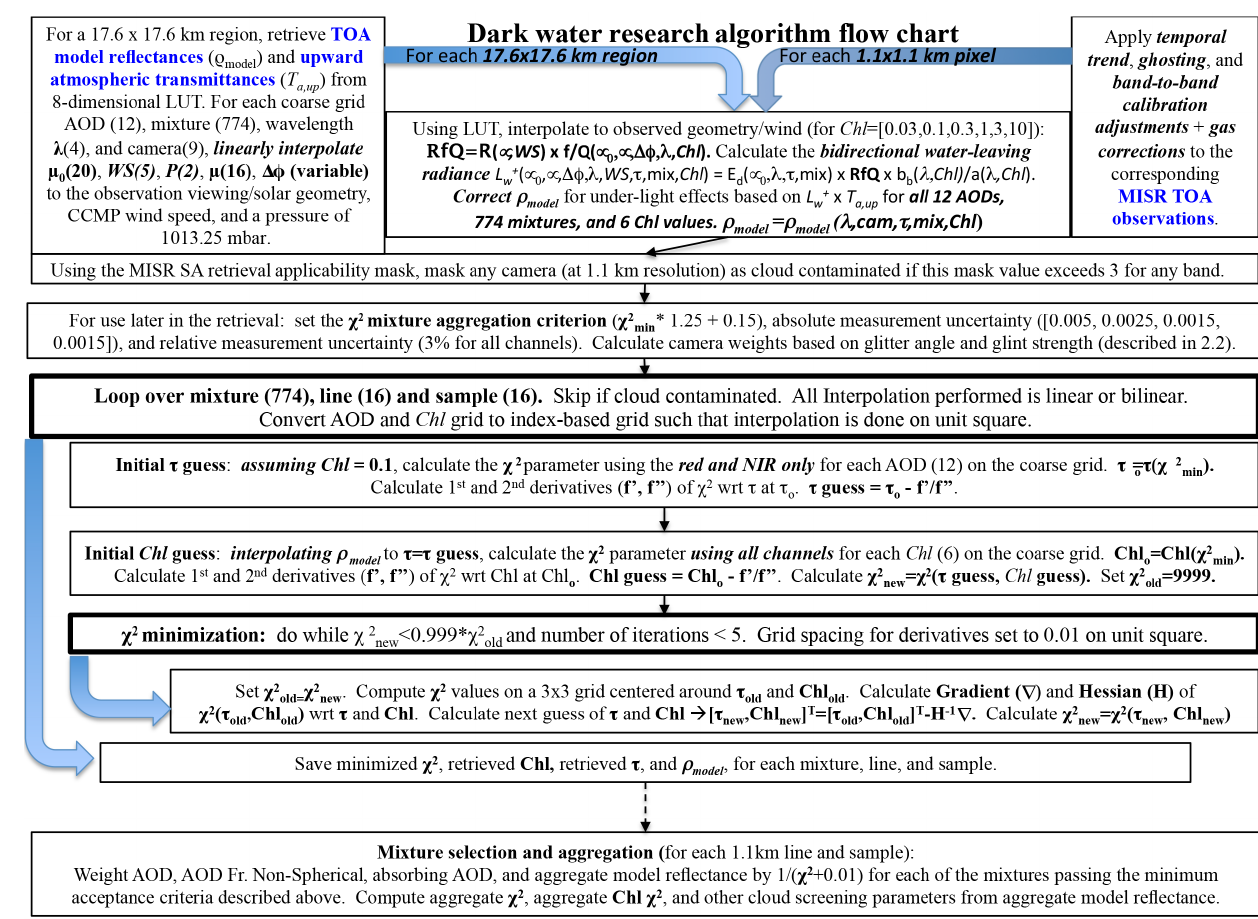
Figure 1. Flow chart describing the MISR RA aerosol/Chl retrieval